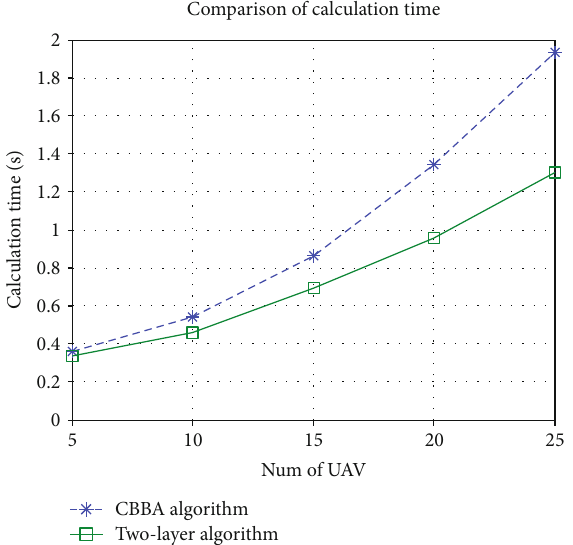
Figure 9: The comparison of calculation time obtained by two types of algorithm.